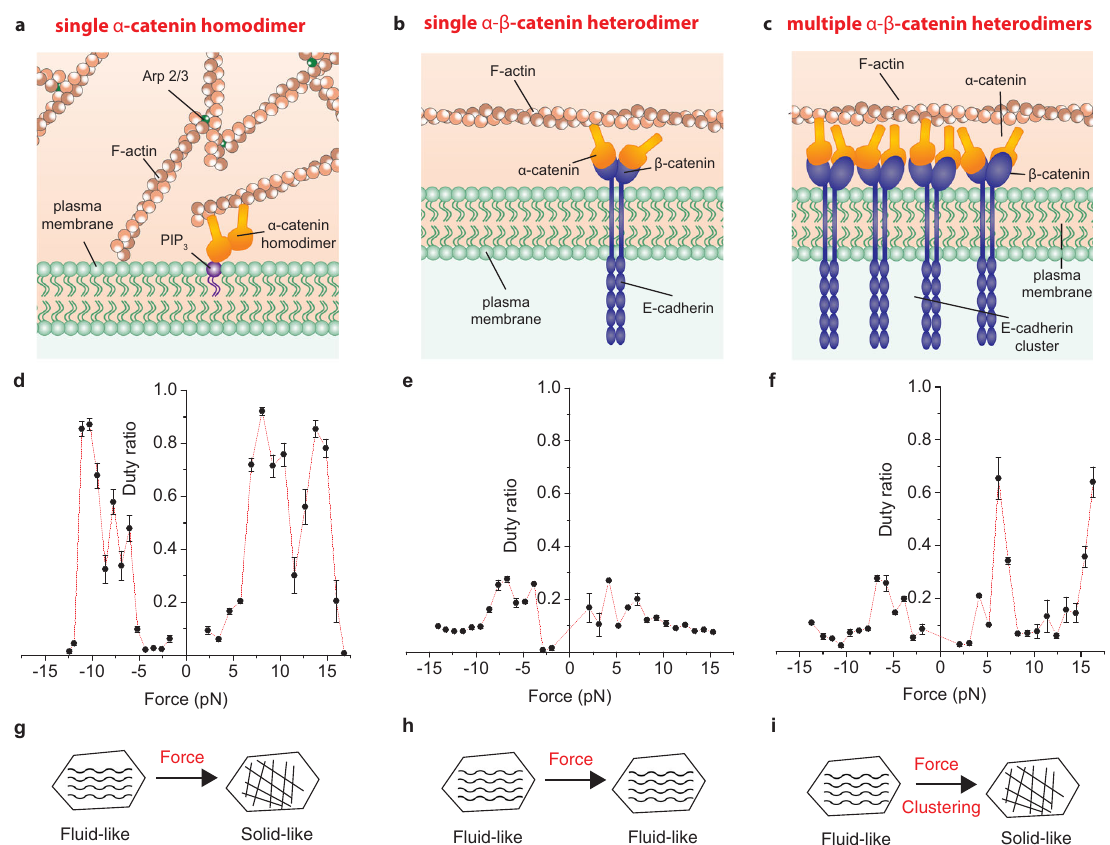
Fig. 5 α -catenin clustering and intracellular tension regulate cell junction fl uidity. a Illustration showing α -catenin in fi lopodia. α -catenin is present in the form of homodimers bound to PIP 3 on the plasma membrane. b Illustration showing α -catenin in immature adherens junctions. α -catenin is present in the cadherin-catenin complexes at low density. c Illustration showing α -catenin in mature adherens junctions. α -catenin is present in the cadherin-catenin complexes which cluster in groups of 5 – 6. d Duty ratio of a single α -catenin homodimer. Forces above 5 pN induce α -catenin unfolding and large increase in duty ratio. n = 23234 total number of interactions for all points in the plot. Error bars, s.e.m. e Duty ratio of a single α - β -catenin heterodimer is not affected by force. n = 360486 total number of interactions for all points in the plot. Error bars, s.e.m. f Duty ratio of multiple α - β -catenin heterodimers. Forces above 5 pN induce α -catenin unfolding and large increase in duty ratio. n = 55171 total number of interactions for all points in the plot. Error bars, s.e.m. g Interaction between a single α -catenin homodimer and F-actin switches from a fl uid to a solid response under force. h Interaction between a single α - β -catenin heterodimer and F-actin is fl uid regardless of the tension on the actin cytoskeleton. i Interaction between multiple α - β -catenin heterodimers and F-actin switches from a fl uid to a solid response under force. Source data are provided as a Source Data fi